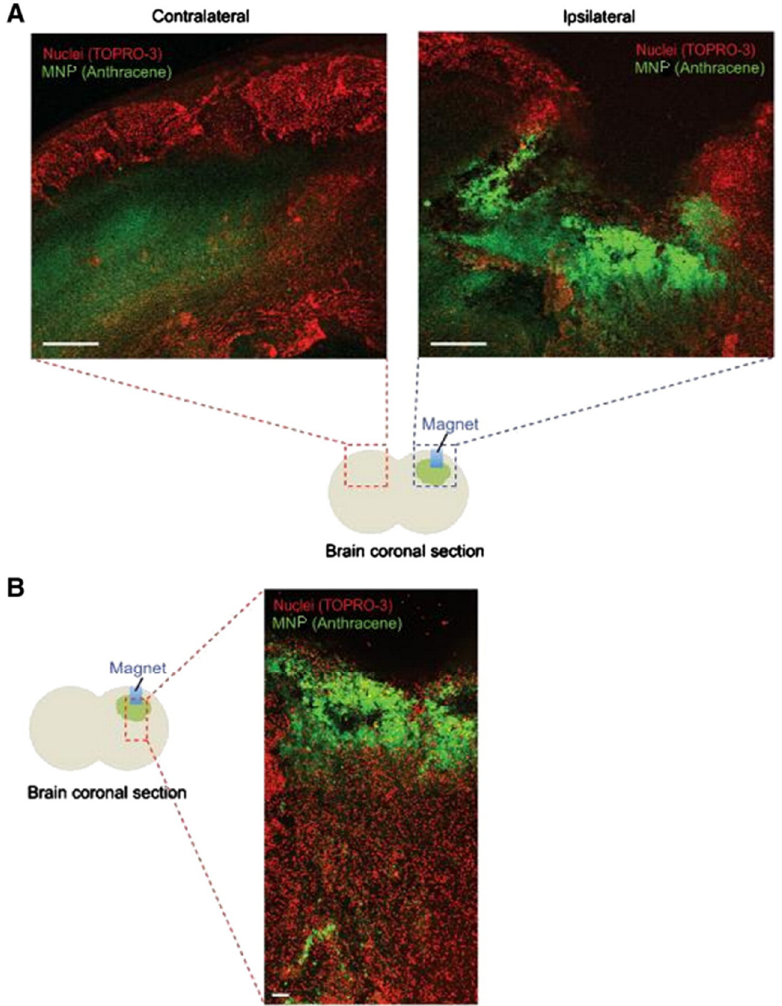
Figure 4. Magnetically vectored magnetic nanoparticles (MNPs) accumulate in the brain. ( A ) A small magnet was implanted in the right hemisphere of the brains of mice by stereotactic injection. (Blue represents the inserted magnet and green shade represents MNPs in cartoon). One week after implantation, MNPs were administered by IV injection. Confocal analysis demonstrated accumulation of the MNPs in the ipsilateral hemisphere, whereas a background level of MNPs was found in the contralateral hemisphere. Scale bar: 500 μ m. ( B ) Confocal analysis of coronal sections of brain demonstrated enrichment of the MNPs near the magnet. Scale bar: 100 μ m. Reproduced with permission of [59]. Copyright Elsevier Science,